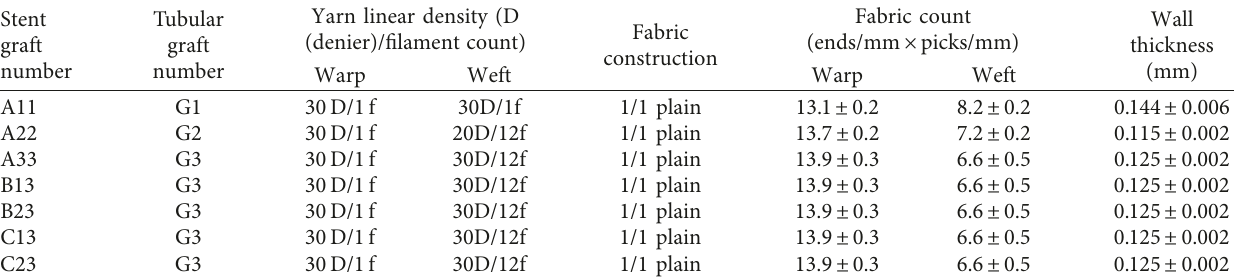
Figure 1: Schematics of (a) Z-stented and (b) M-stented grafts. ( H 1 refers to the stent spacing, H 2 refers to the height of one stent strut, H 3 is half of H 2 , and α refers to the stent apex angle.) Table 1: Textile structural parameters of seamless tubular